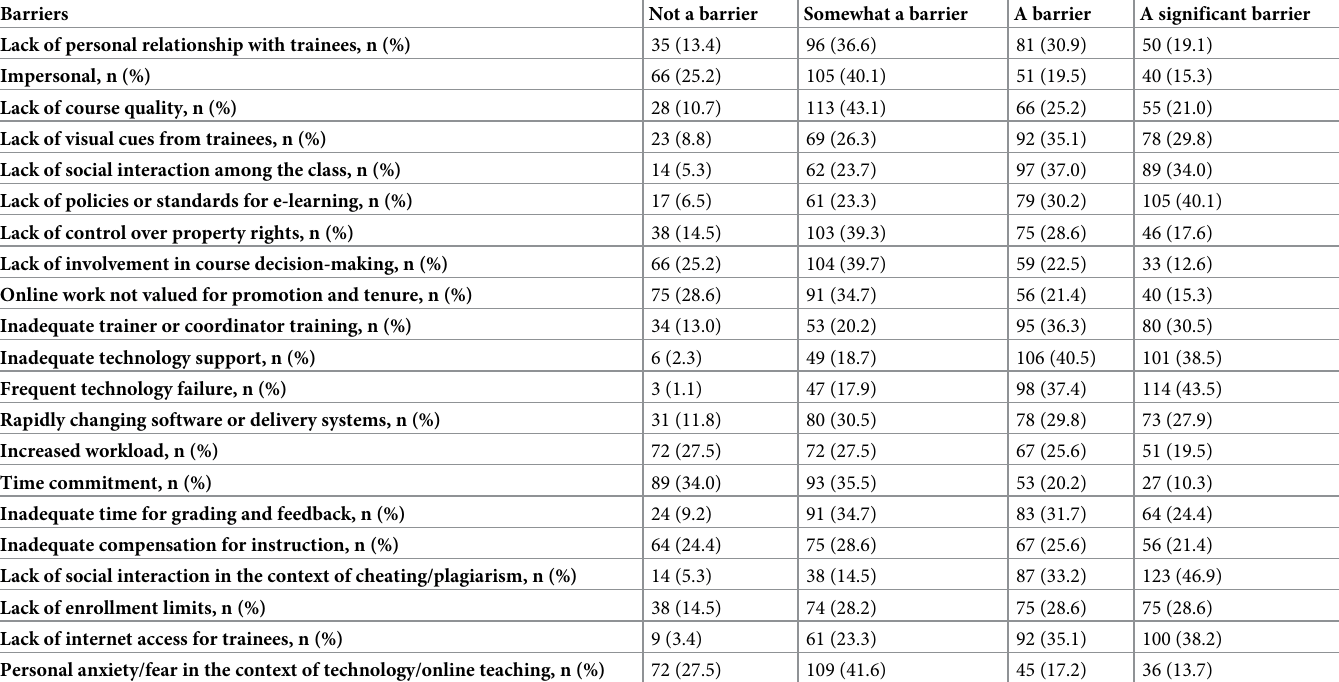
Table 3. Barriers to e-learning experienced by trainers and coordinators in the Saudi MOH during the COVID-19 pandemic.